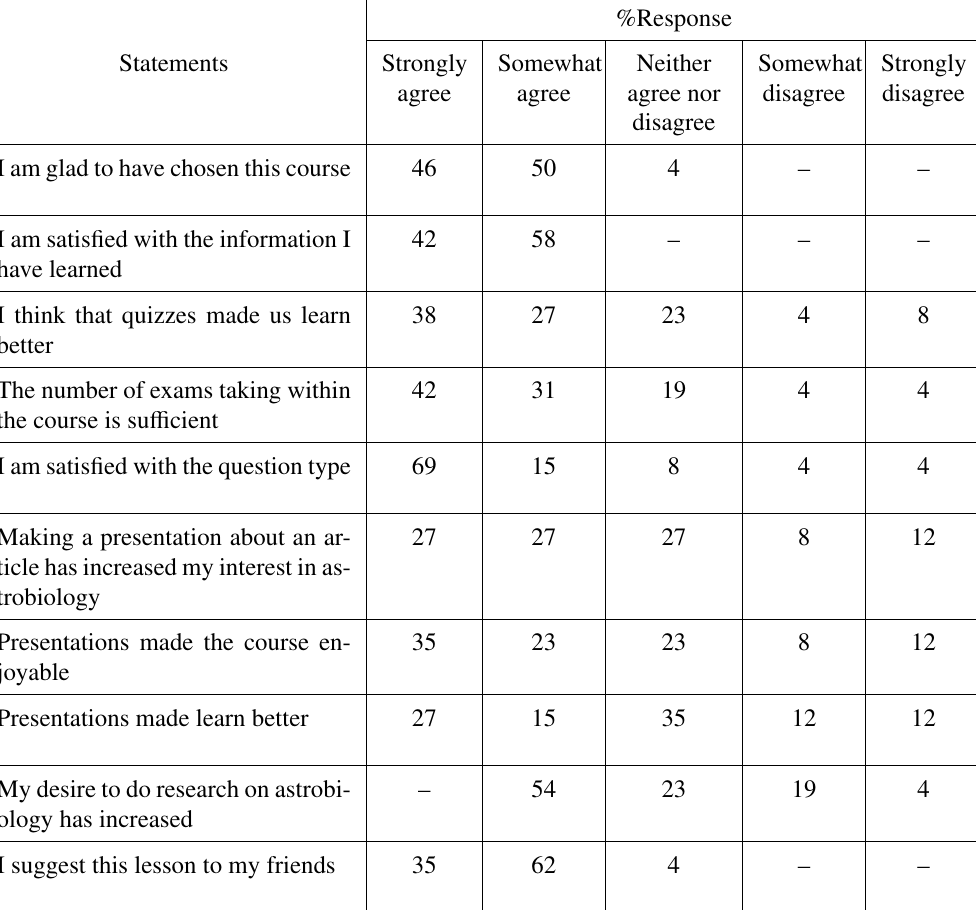
Table 3. The degree of satisfaction of the students with the Astrobiology